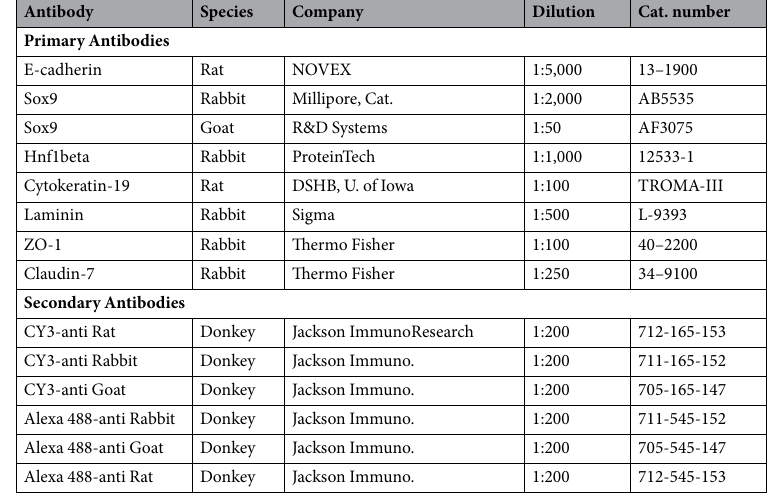
Table 1. Primary and secondary antibodies used in immunostaining